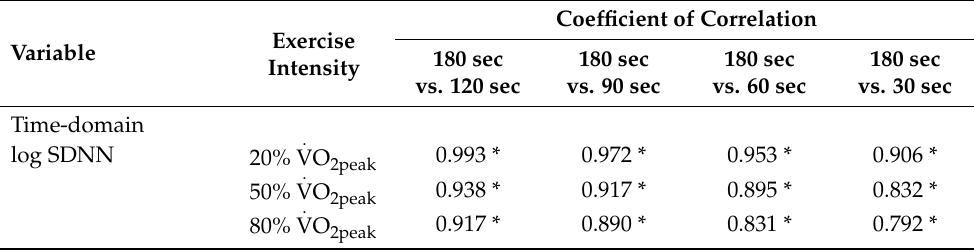
. . VO 2peak ; †, p < 0.05 vs. 50% VO 2peak . ． O 2peak ; †, p < 0.05 vs. 50%